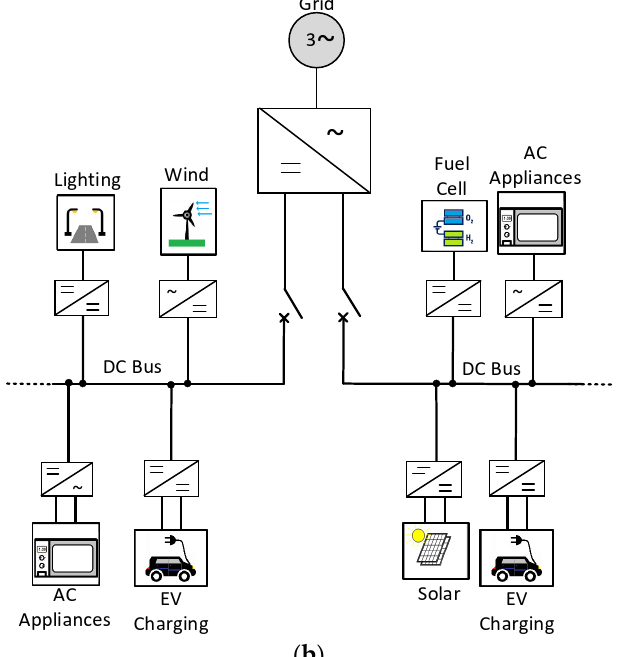
Figure 2. A schematic of typical example of the radial topology: ( a ) series configuration and ( b ) parallel configuration.